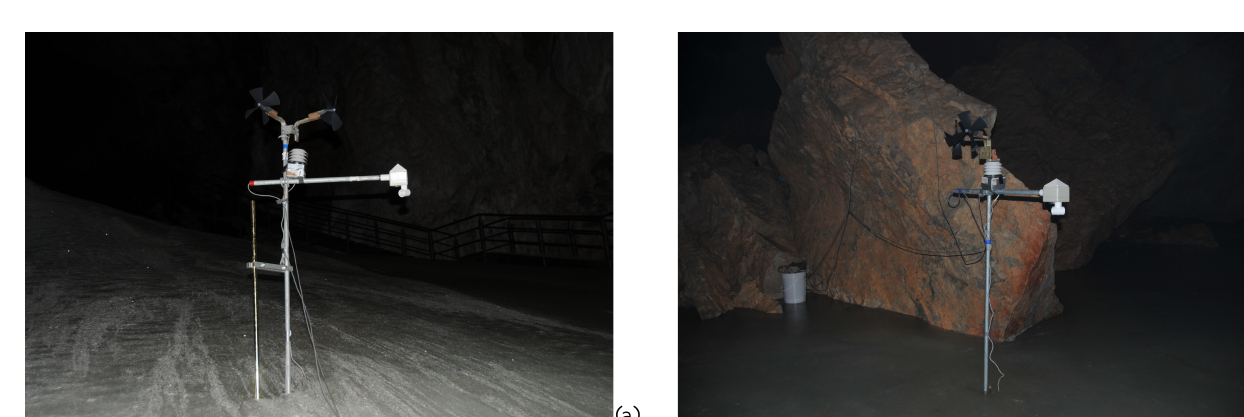
Fig. 3. The automatic weather station AWS close to the cave entrance at site Posselthalle (a) and in the central part of Eisriesenwelt at site Odinsaal (b) (see Fig. 1 for location of the